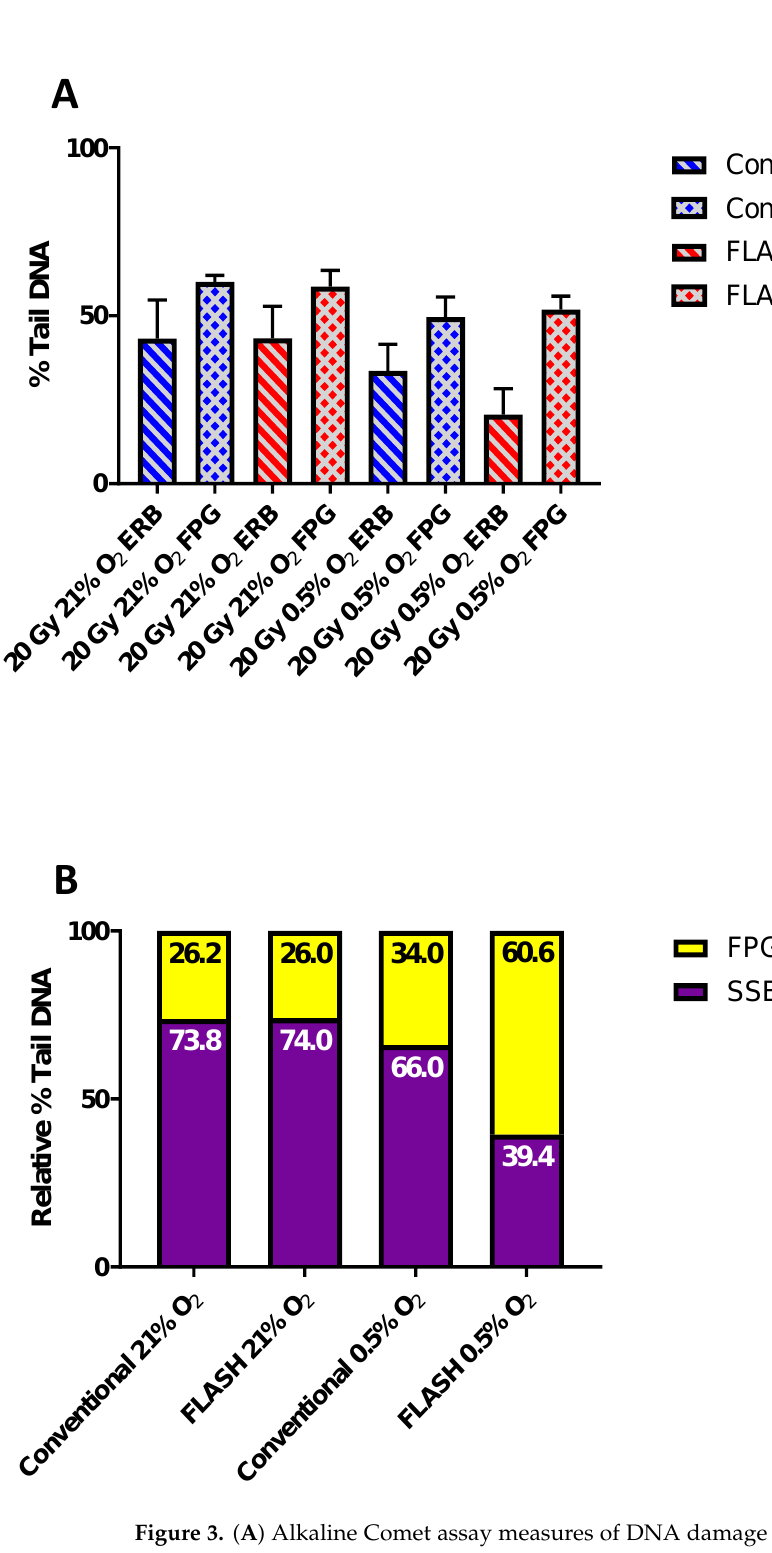
Figure 3. ( A ) Alkaline Comet assay measures of DNA damage formation (% Tail DNA) in whole- blood peripheral blood lymphocytes (WB-PBL) following 20 Gy CONV or FLASH irradiation at 21 or 0.5% O 2 , and treatment of the post-lysis-generated nucleoids with either FPG (0.1 U per gel) (columns 2, 4, 6, and 8) or ERB-only (columns 1, 3, 5, and 7). Data are expressed as the mean % Tail DNA of three slides ( n = 3). Error bars indicate standard deviation of the means for each experimental condition. ( B ) The determined relative levels of induced strand break damage (SSB) vs. FPGss following 20 Gy CONV or FLASH irradiation at 21 or 0.5% O 2